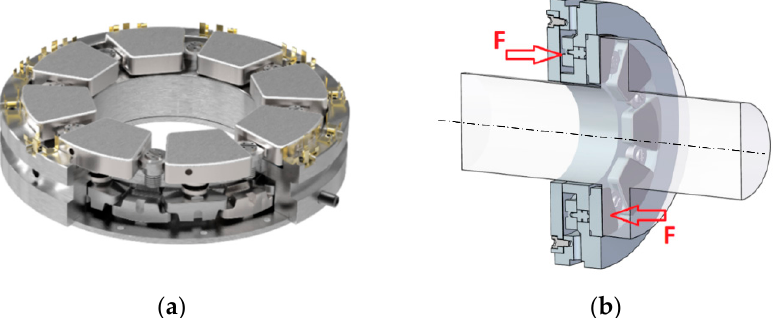
Figure 1. Axial slide bearing with the self-equalizing segment, ( a ) real view; ( b ) illustration of force transfer by means of levers.